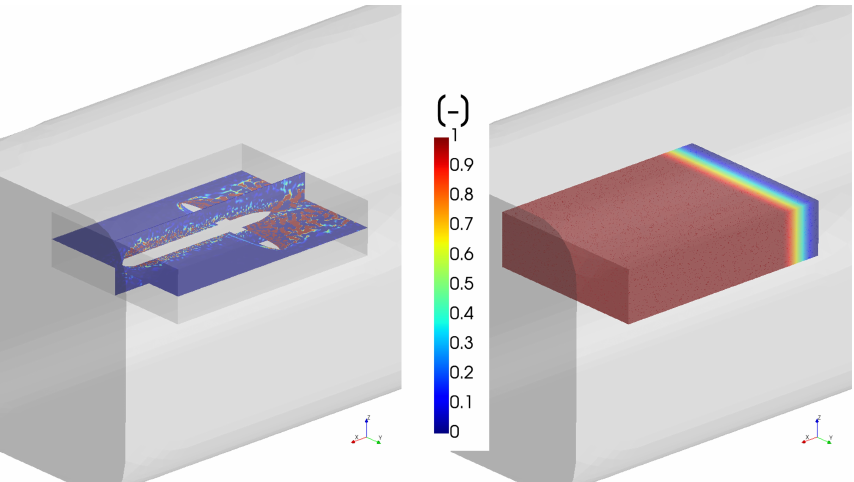
Figure 27. Noise sources (left side) and the spatial filter distributions in the CFD mapping